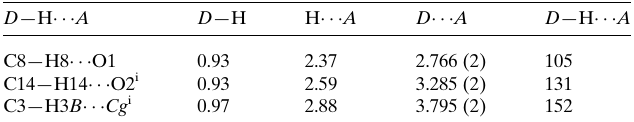
Table 1 Hydrogen-bond geometry (A˚ , (cid:3) ) for (I). Cg is the centroid of the C22–C27 ring.